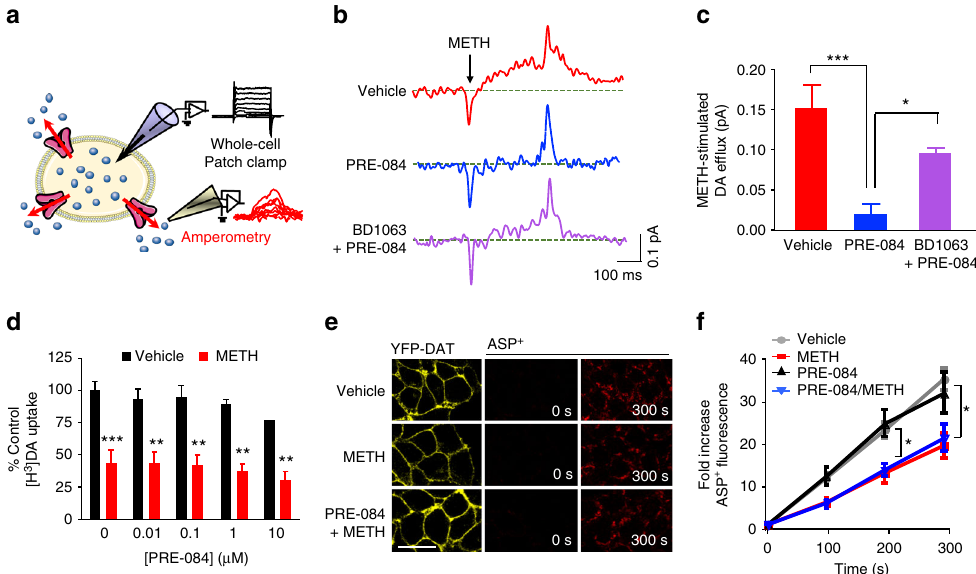
Fig. 3 σ 1 R activation decreases METH-stimulated dopamine ef fl ux without affecting uptake. a Schematic of the setup is shown. YFP-DAT cells loaded with dopamine were voltage clamped while oxidative currents were measured via an amperometric electrode. Dopamine is represented in purple and DAT in pink. Cell, molecules, and proteins images are courtesy of Servier Medical Art, licensed under CC BY 3.0 (https://creativecommons.org/licenses/by/3.0/ legalcode). b Representative traces show METH-stimulated (10 µ M) dopamine ef fl ux after 30-min treatment with vehicle, 1 µ M PRE-084, or 1 µ M BD1063 plus 1 µ M PRE-084. METH increased dopamine ef fl ux (top panel), while PRE-084 signi fi cantly decreased the effect of METH (middle panel). BD1063 blunted the effect of PRE-084. c Bar graph shows the average METH-stimulated dopamine ef fl ux above baseline following treatment with vehicle, PRE- 084, or BD-1063 + PRE-084 ( n = 4, 4, and 6 cells, respectively, F (2,11) = 15.18, P = 0.0007, one way ANOVA; Tukey ’ s test for multiple comparisons, * P < 0.05 and *** P < 0.001). d [ 3 H]DA uptake was measured in FLAG-DAT cells. 10 μ M METH (15 min) signi fi cantly decreased [ 3 H]DA uptake compared